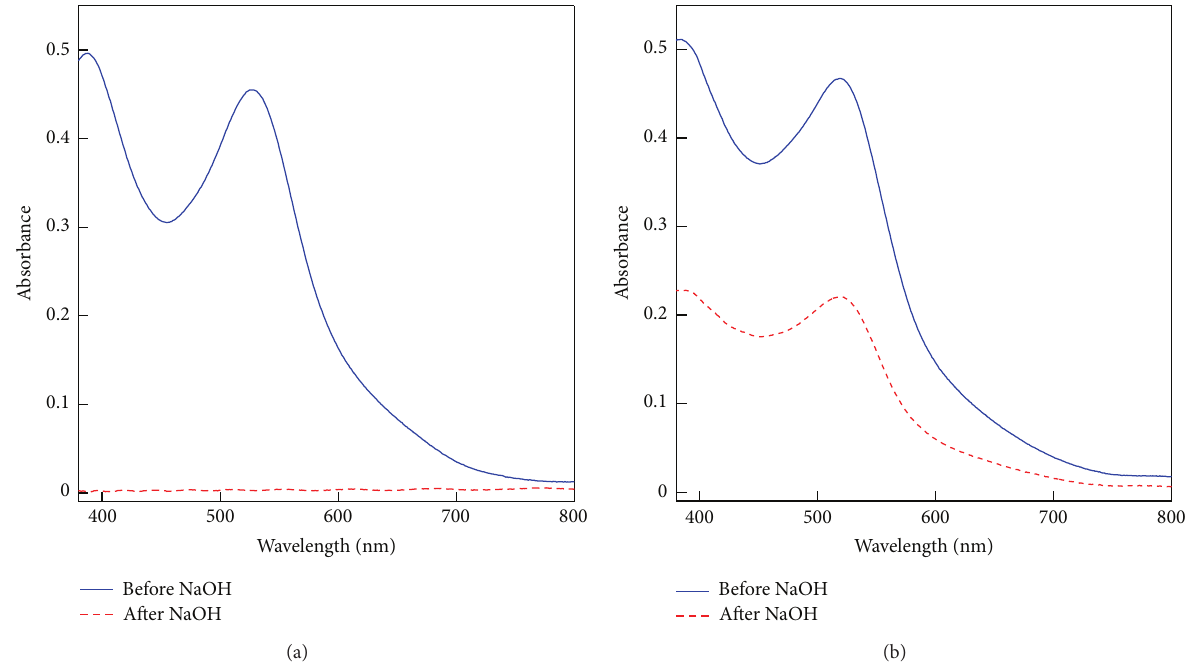
Figure 5: Absorption spectra of Ru-dye (N719 (a) and Z907 (b)) adsorbed TiO 2 nanocrystalline electrodes. Each dyed electrode was dipped in NaOH aq. , and the difference of absorbance was